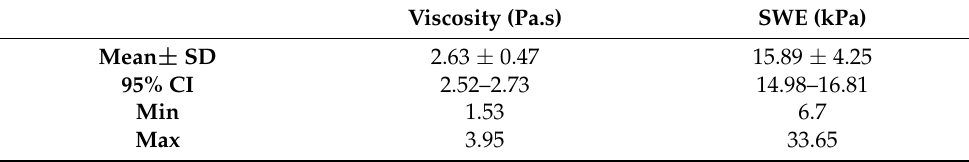
Table 3. Mean viscosity and stiffness values of thyroid parenchyma in healthy